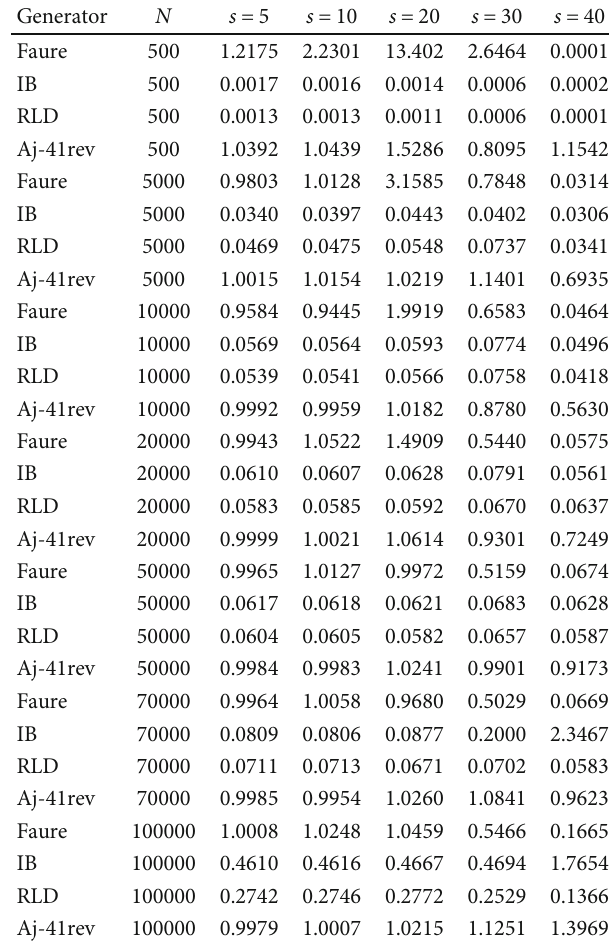
ð f Þ by using Faure 1